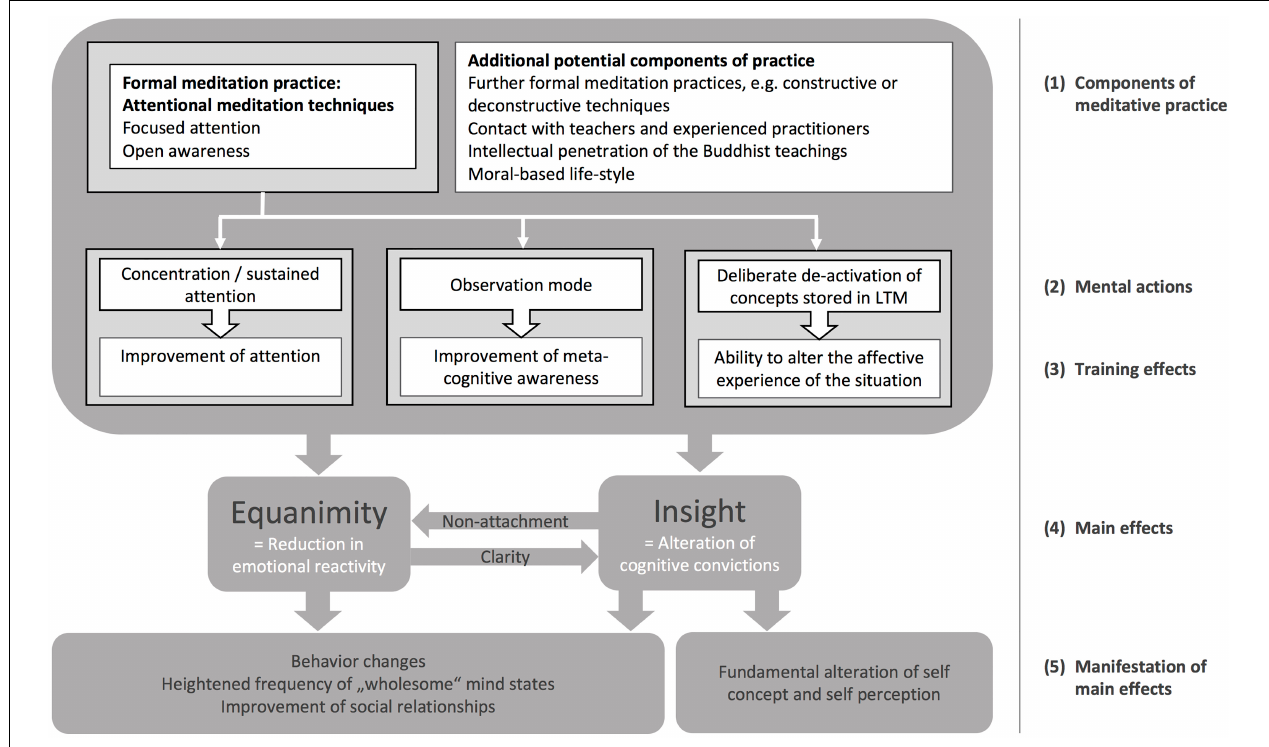
FIGURE 1 | The general process of meditative